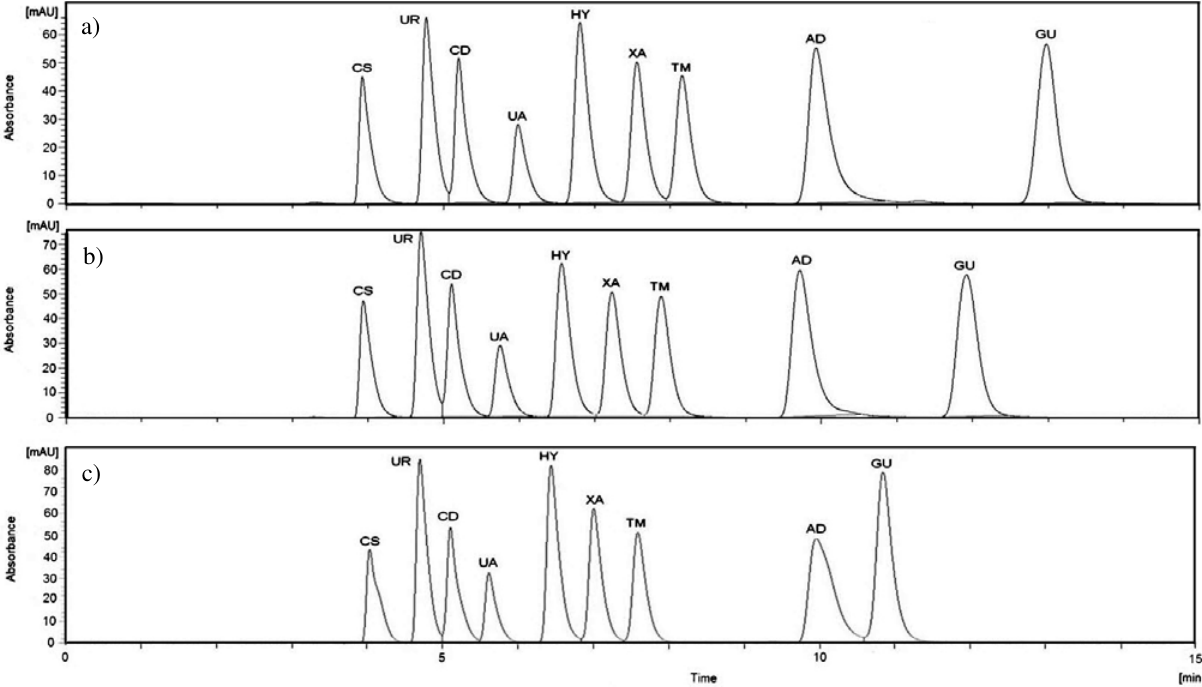
Figure 3. Chromatograms of nine 50 μM nucleobases in acetate buffer of pH 4.0 and 3% MeOH of different total concentrations : a) 0.05 M, b) 0.1 M, and c) 0.2